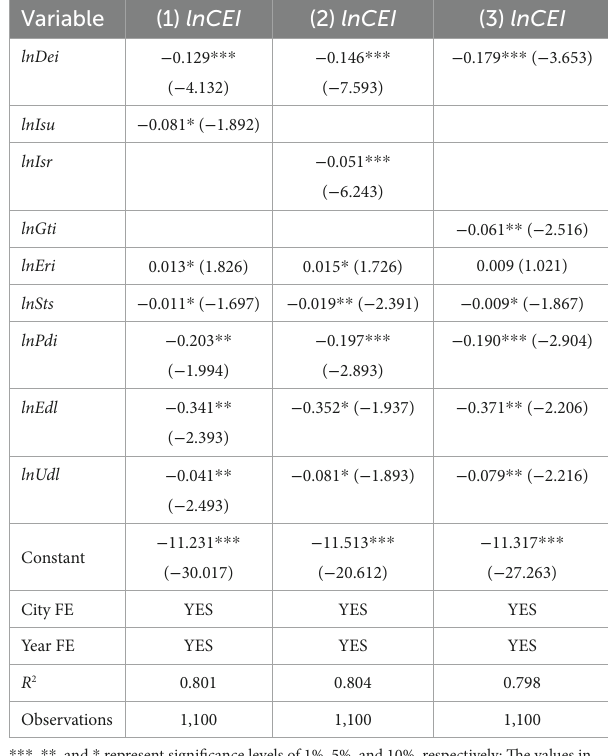
TABLE 5 Mediating variables and